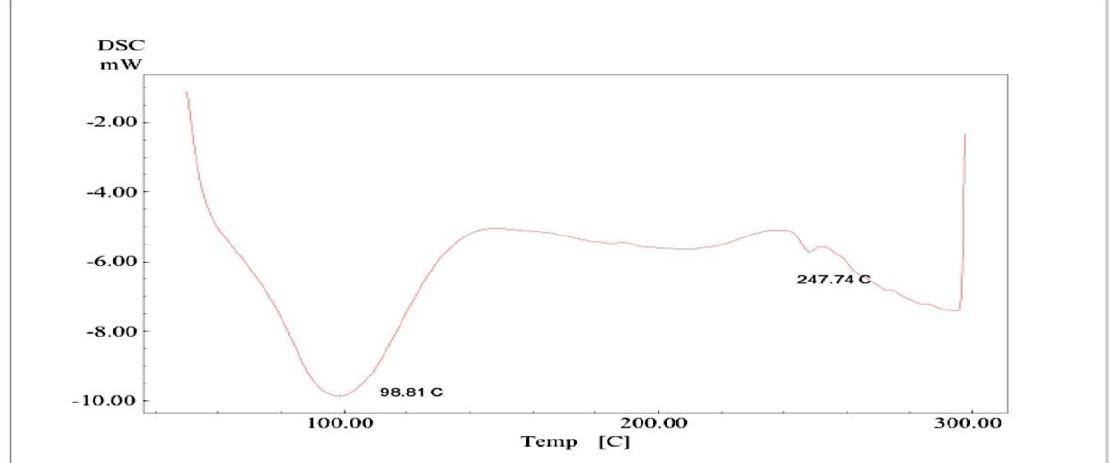
Figure 19. DSC thermogram of domperidone nanoparticles (F8)